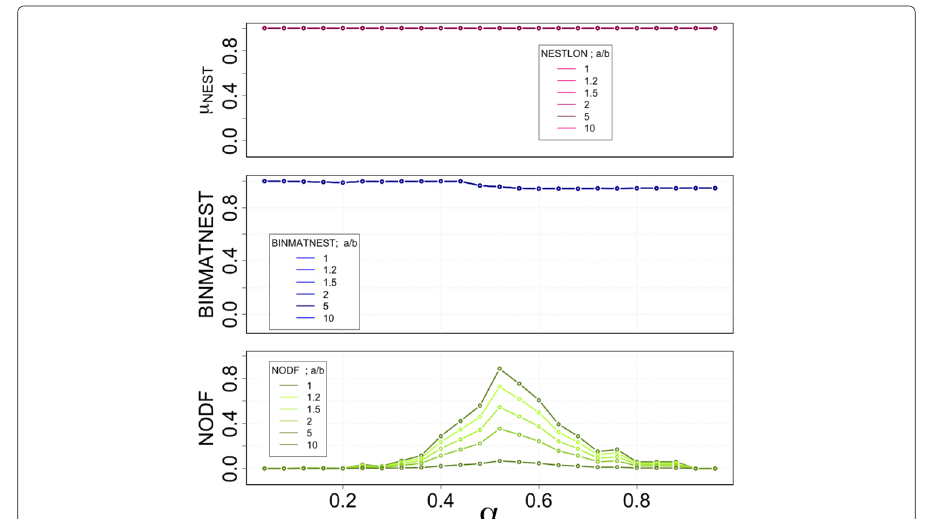
Fig. 6 Sensitivity analysis among NESTLON, BINMATNEST, and NODF on a benchmark graph without added noise. The sensitivity in nestedness under the variation of the matrix shape (i.e. n a / n b ) is much higher for the method NODF than for the two other methods BINMATNEST and NESTLON. We perform the computation on a bipartite graph of set size n b = 100